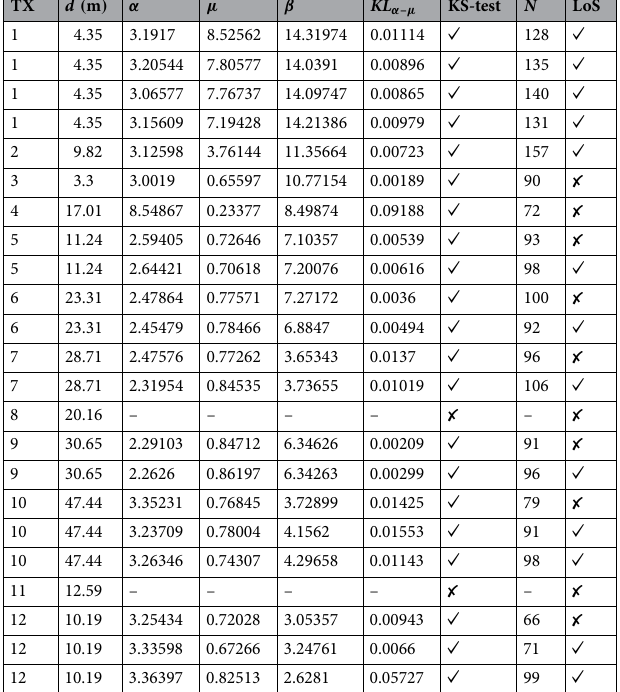
Table 5. Aalto university entrance hall links parameters of the α – µ distribution.